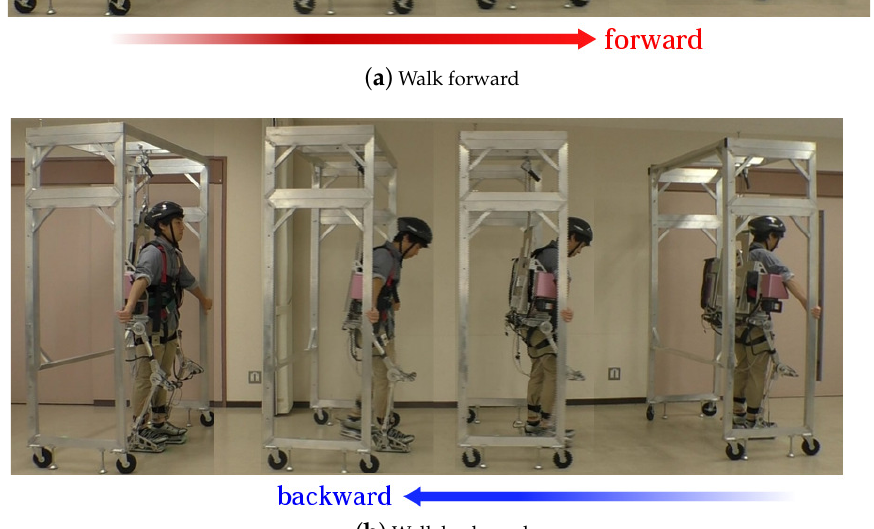
Figure 6. Data acquisition for database construction: the wearer walks forward and backward wearing the powered exoskeleton while it is lifted by a gantry and pushes the gantry himself.